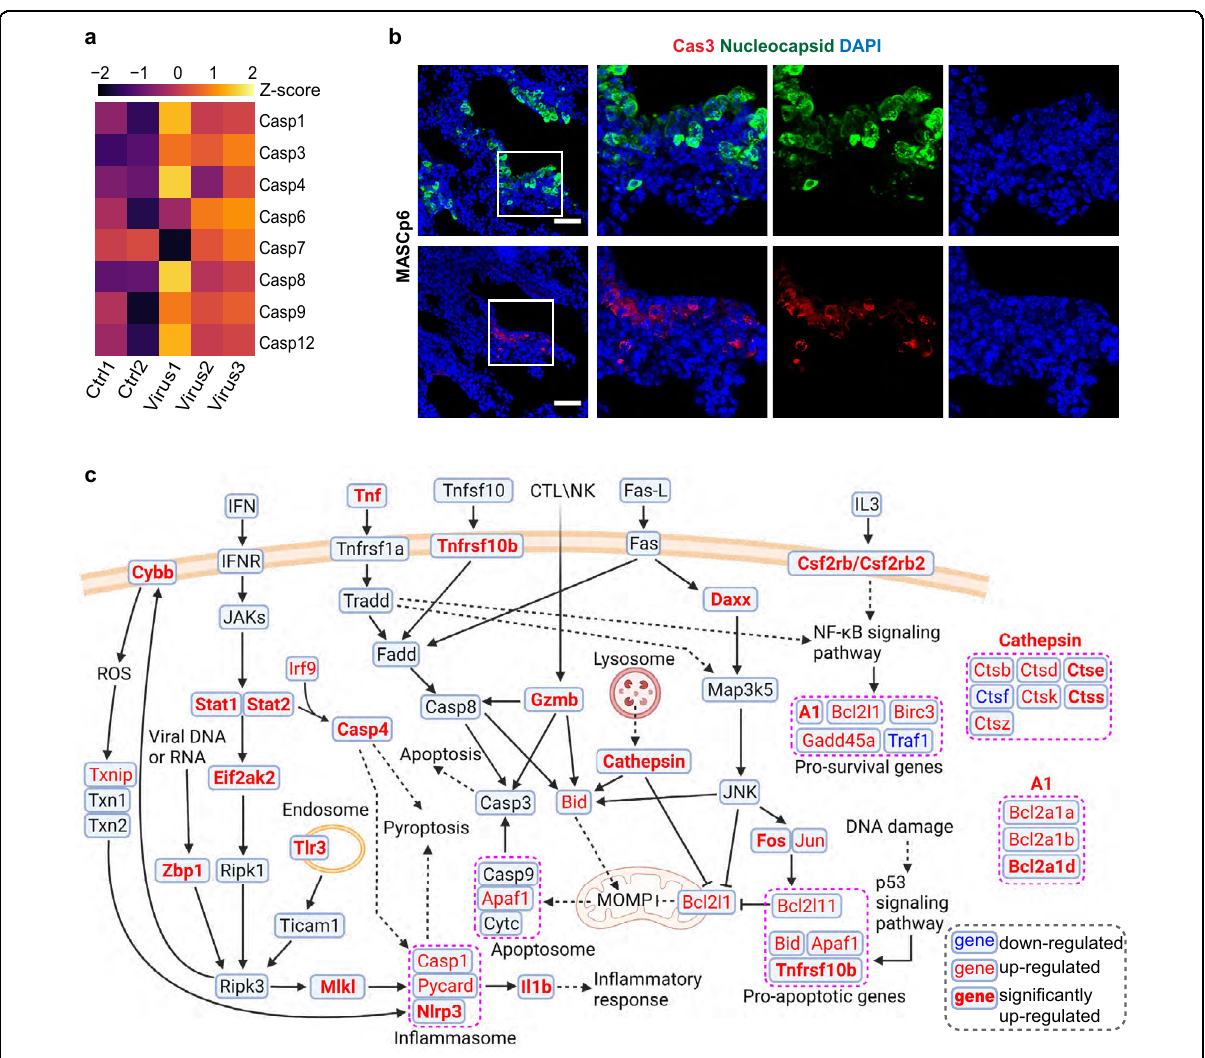
Fig. 2 MASCp6 infection leads to cell death in the lungs. a Heatmap shows relative expression levels of caspase family genes in the RNA-seq data. b Immunostaining results with SARS-CoV-2 nucleocapsid (green) and activated form of caspase 3 (Cas3, red) antibodies of lung sections from MASCp6-infected and control aged mice. Scale bars, 50 μ m. c Schematic diagram (created in BioRender.com) of apoptosis and necroptosis pathways. MOMP, mitochondrial outer membrane permeabilization. Downregulated: P < 0.05 and FC < 1; upregulated: P < 0.05 and FC > 1; signi fi cantly upregulated: P < 0.05 and FC >